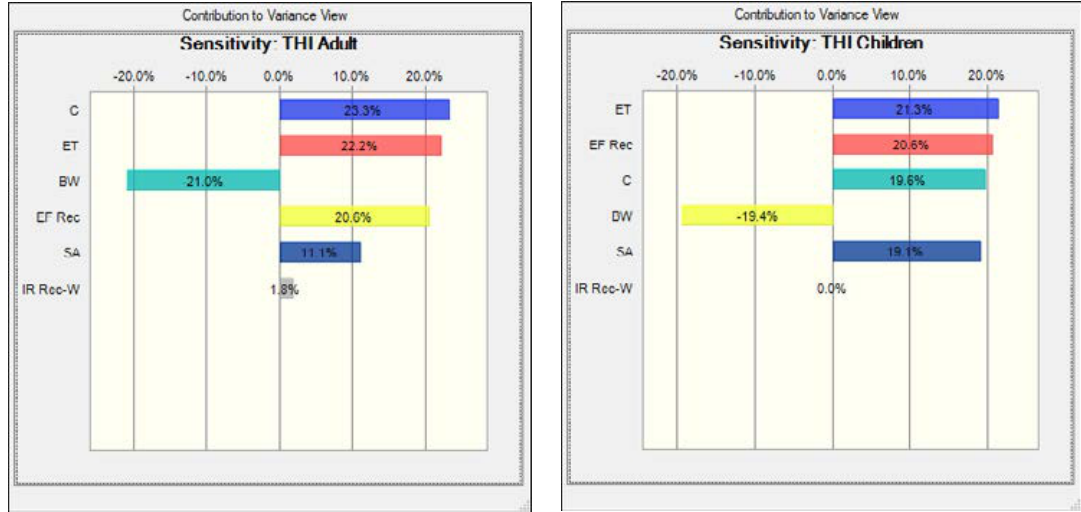
Fig. 3: Sensitivity analysis for all selected variables in health risk Table 3: The percent reduction of polymer sulfur (PS) to total Hg concentration in coastal water of Makassar City Sampling